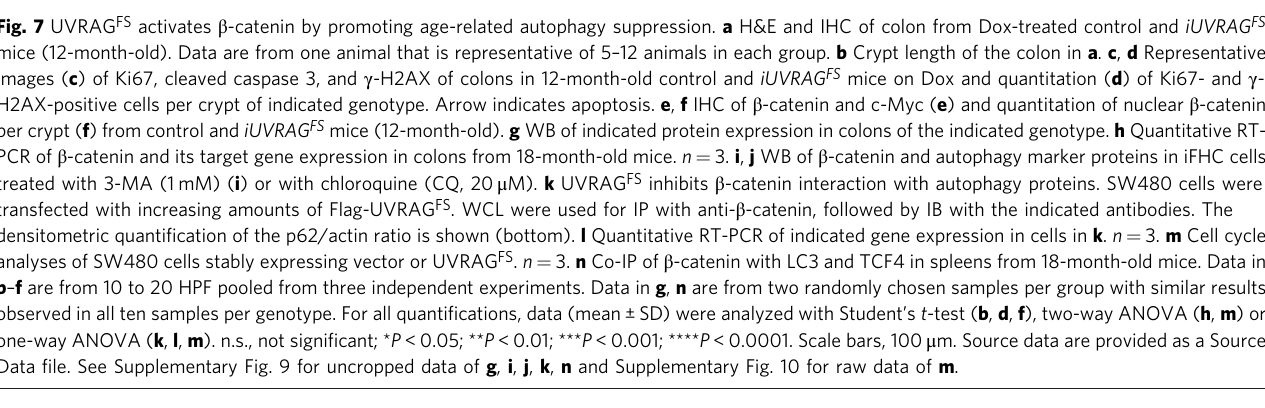
Fig. 7 UVRAG FS activates β -catenin by promoting age-related autophagy suppression. a H&E and IHC of colon from Dox-treated control and iUVRAG FS mice (12-month-old). Data are from one animal that is representative of 5 – 12 animals in each group. b Crypt length of the colon in a . c , d Representative images ( c ) of Ki67, cleaved caspase 3, and γ -H2AX of colons in 12-month-old control and iUVRAG FS mice on Dox and quantitation ( d ) of Ki67- and γ - H2AX-positive cells per crypt of indicated genotype. Arrow indicates apoptosis. e , f IHC of β -catenin and c-Myc ( e ) and quantitation of nuclear β -catenin per crypt ( f ) from control and iUVRAG FS mice (12-month-old). g WB of indicated protein expression in colons of the indicated genotype. h Quantitative RT- PCR of β -catenin and its target gene expression in colons from 18-month-old mice. n = 3. i , j WB of β -catenin and autophagy marker proteins in iFHC cells treated with 3-MA (1 mM) ( i ) or with chloroquine (CQ, 20 μ M). k UVRAG FS inhibits β -catenin interaction with autophagy proteins. SW480 cells were transfected with increasing amounts of Flag-UVRAG FS . WCL were used for IP with anti- β -catenin, followed by IB with the indicated antibodies. The densitometric quanti fi cation of the p62/actin ratio is shown (bottom). l Quantitative RT-PCR of indicated gene expression in cells in k . n = 3. m Cell cycle analyses of SW480 cells stably expressing vector or UVRAG FS . n = 3. n Co-IP of β -catenin with LC3 and TCF4 in spleens from 18-month-old mice. Data in b – f are from 10 to 20 HPF pooled from three independent experiments. Data in g , n are from two randomly chosen samples per group with similar results observed in all ten samples per genotype. For all quanti fi cations, data (mean ± SD) were analyzed with Student ’ s t -test ( b , d , f ), two-way ANOVA ( h , m ) or one-way ANOVA ( k , l , m ). n.s., not signi fi cant; * P < 0.05; ** P < 0.01; *** P < 0.001; **** P < 0.0001. Scale bars, 100 μ m. Source data are provided as a